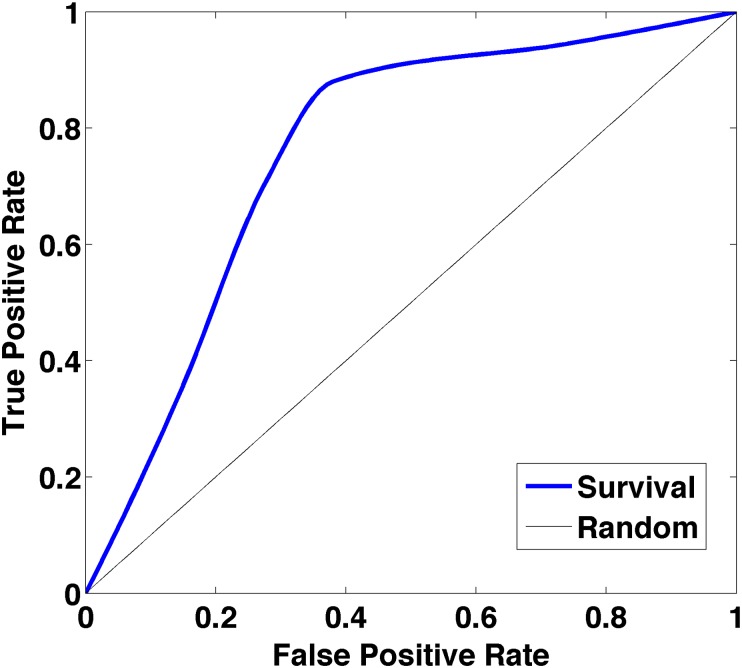
ROC curve for the prediction of survival at the 12-month time point.The x-axis is the false- positive rate, 1 –specificity; the y-axis is the true- positive rate, sensitivity. The area under the ROC curve is 0.76.